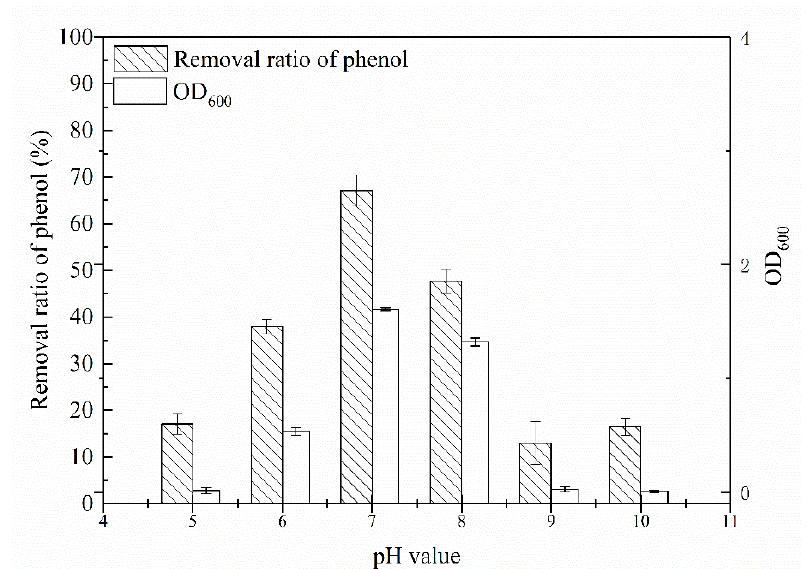
Figure 3. E ff ects of di ff erent initial pH values on removal ratio of phenol at 500.0 mg / L at 30 ◦ Figure 3. Effects of different initial pH values on removal ratio of phenol at 500.0 mg/L at 30 °C